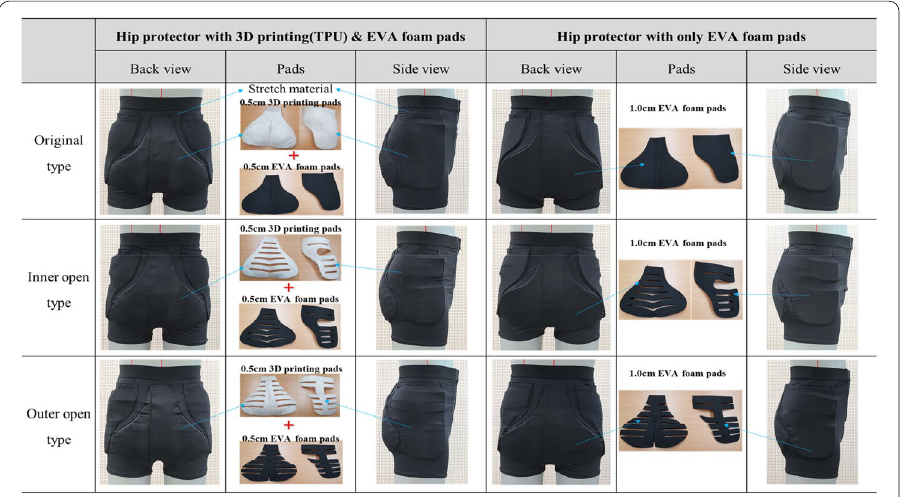
Fig. 5 Shapes of hip protectors and pads placed on a male